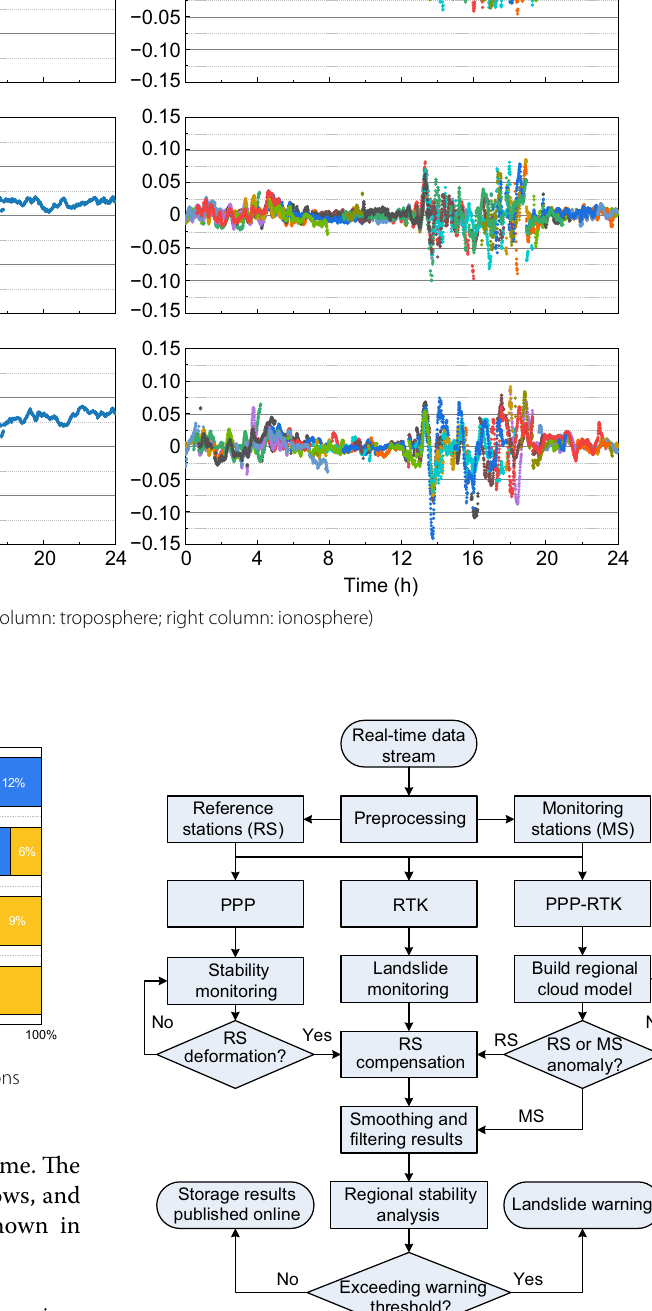
(1) Data preprocessing. The cloud platform receives and synchronizes the data streams from the moni- toring area in real-time, organizes and classifies the data for storage, and simultaneously performs real- time quality control for the data.